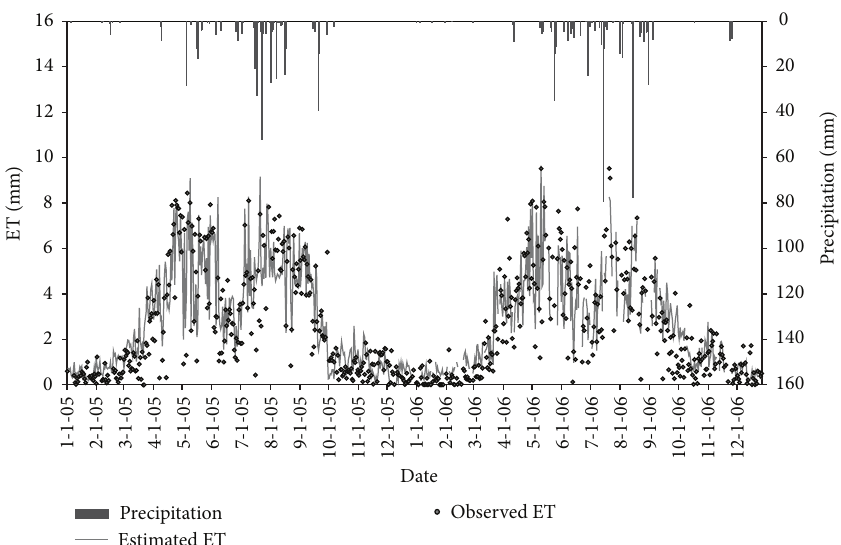
Figure 4: The rainfall (column), the model estimates Eta (line), and the Lysimeters observed Eta (point) from 2005 to 2006.